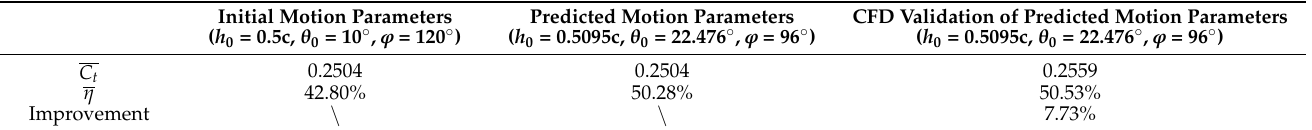
Table 4. Optimized propulsion performance and traditional comparison results and errors.